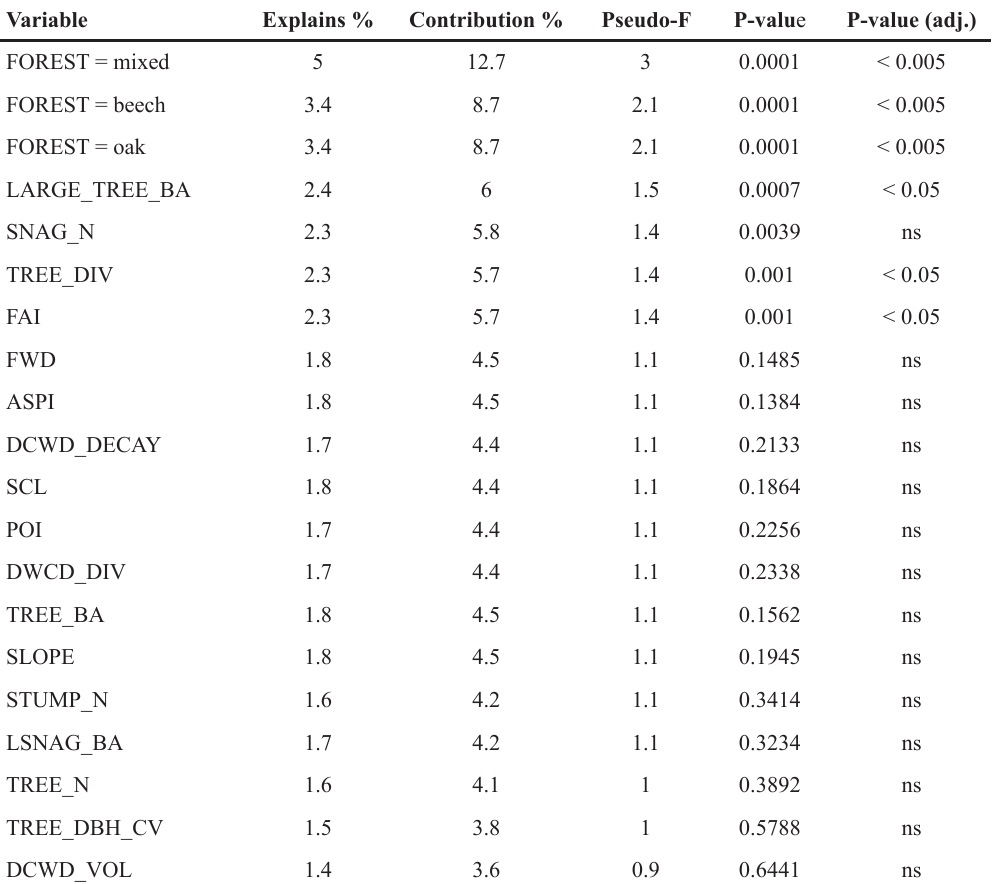
Table 3 – Results of the forward selection in CCA ordination and effects of biotic and abiotic variables on the composition of fungal assemblages. Full names of variables ar available in table